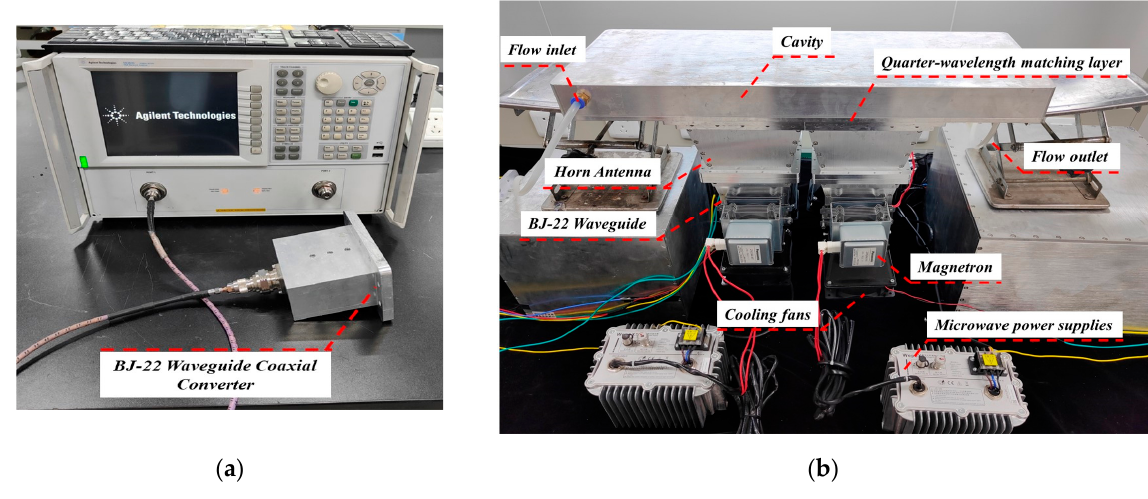
Figure 5. ( a ) Vector network analyzers (VNA); ( b ) photo of the experimental